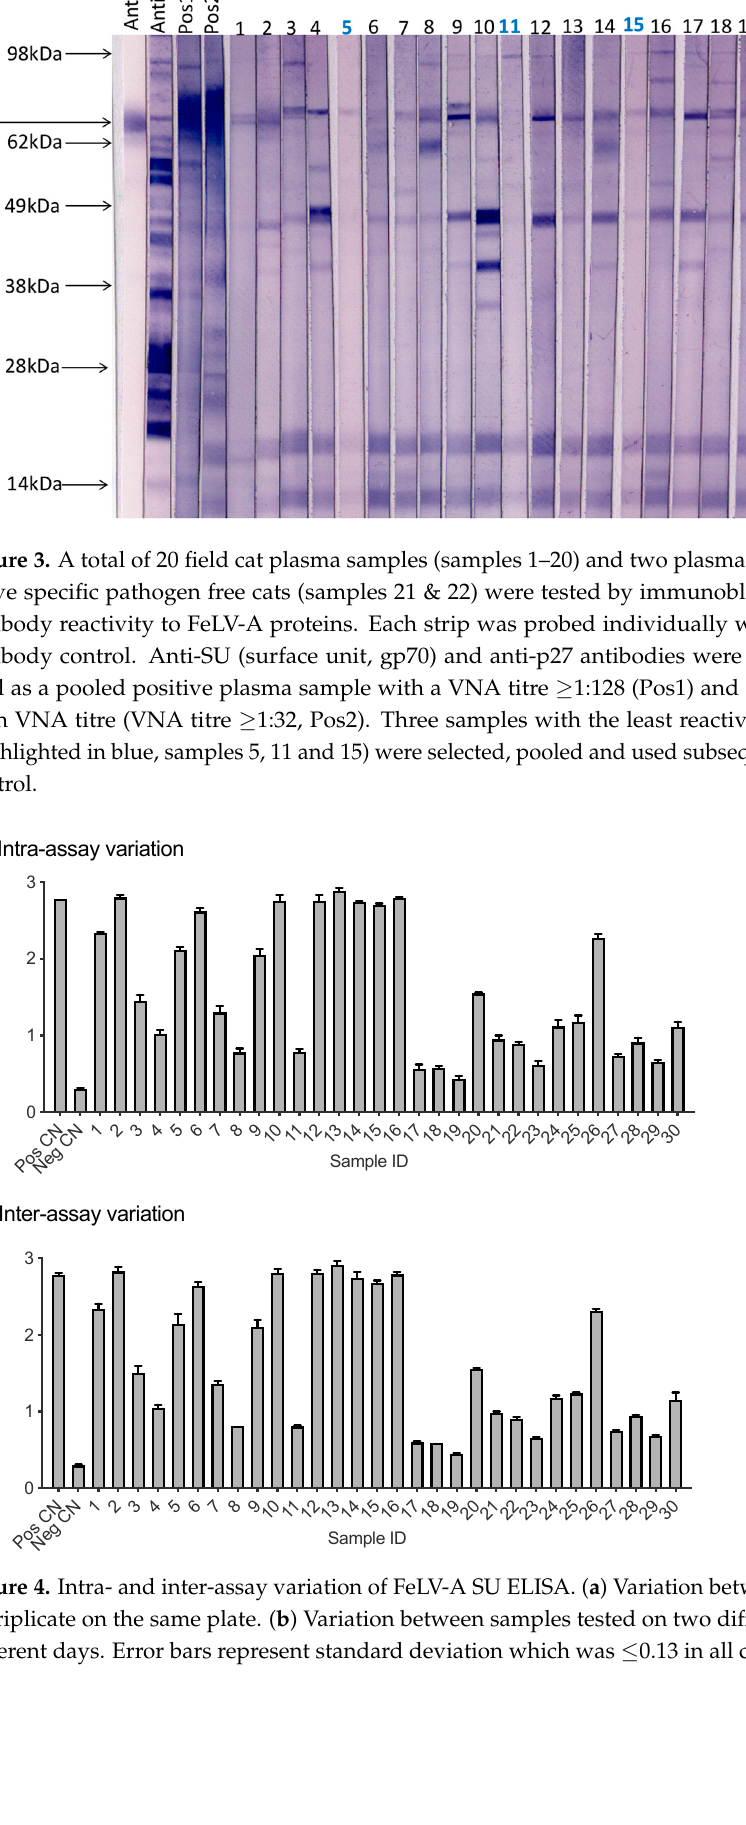
Figure 5. Inter-assay variation of FeLV-A and FeLV-B SU ELISA. The positive control comprised plasma collected and pooled from experimentally infected cats known to have a high VNA titre against FeLV-A. The negative control comprised pooled plasma samples that showed low reactiv- ity to FeLV-A by immunoblot. Error bars represent standard deviation values which were ≤ 0.11 in all cases. Next, samples submitted to IDEXX Laboratories (Westbrook, Maine, USA) for FeLV testing were tested on the FeLV-A SU ELISA, the FeLV-B SU ELISA and by immunoblot